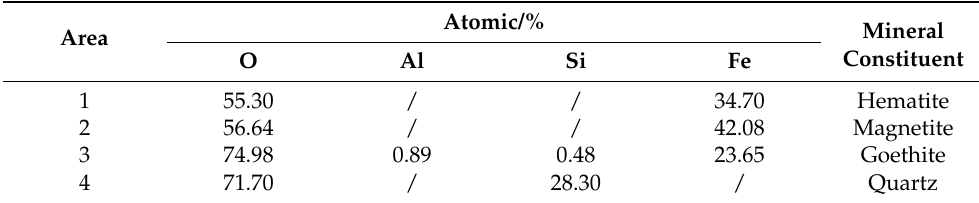
Table 4. EDS analysis results for areas in Figure 2.